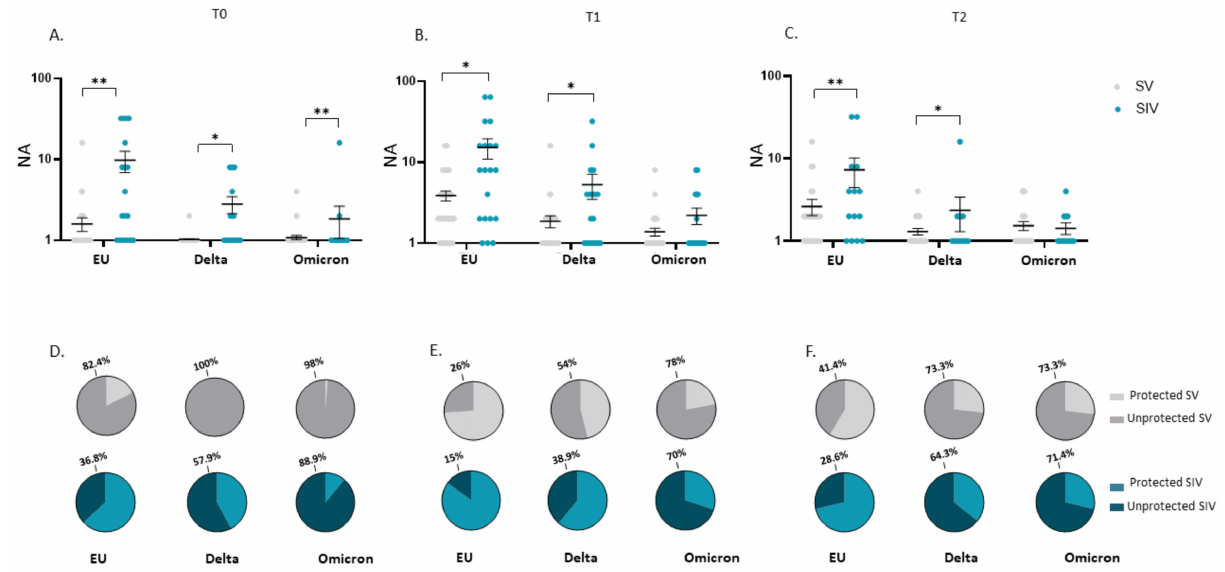
Figure 7. Comparison of saliva neutralizing activity (NA) in SARS-CoV-2 Vaccinated Subjects (SV) and SARS-CoV-2 Vaccinated and infected Subjects (SIV). NA in saliva from SIV was higher than in SV against all the examined VOCs at all time points: T0 ( A ), T1 ( B ), and T2 ( C ). Mean values ± SE are reported. * p < 0.05, ** p < 0.01. Pie charts showing the percentage of SV (grey) and SIV (blue) who do not have NA against the EU, Delta, and Omicron variants at T0 ( D ), T1 ( E ), and T2 ( F ). * p < 0.05, ** p <